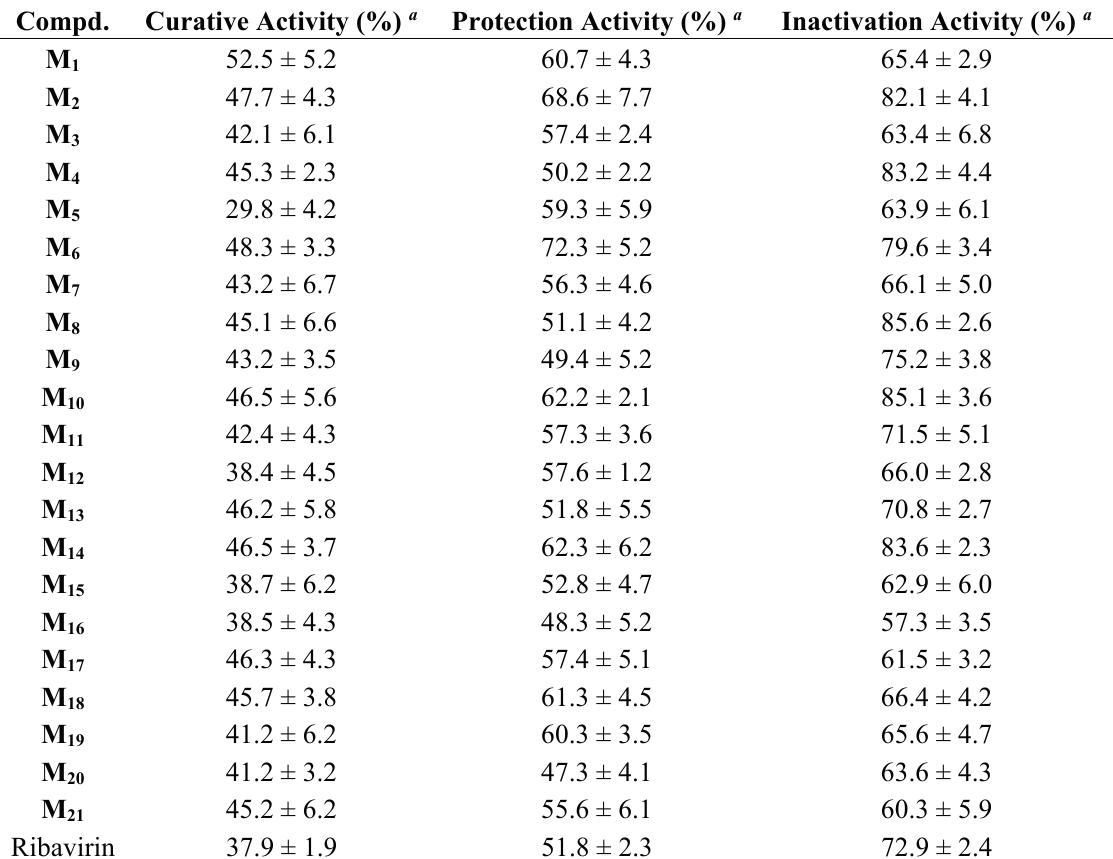
Table 1. Antiviral activities of the test compounds against tobacco mosaic virus (TMV) in vivo at 500 μ